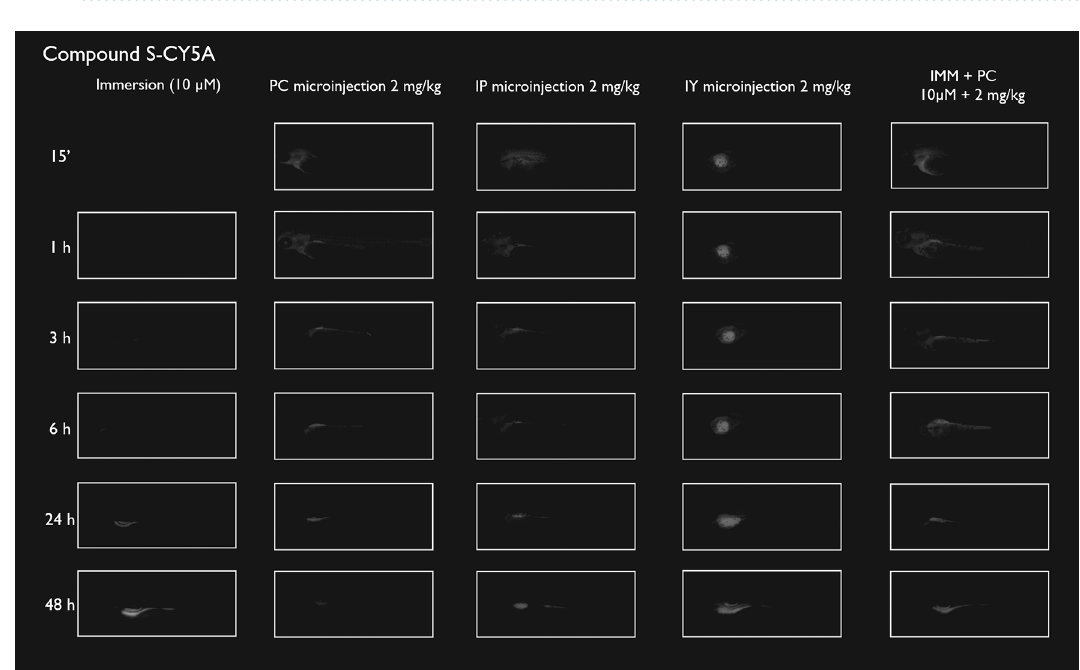
Figure 3. Representative pictures of the spatiotemporal distribution of the fluorescent compound S-CY5A. The eleuthero-embryos were exposed to the dye by immersion (10 µM) or microinjection (2 mg/kg) in the pericardial cavity (PC), intraperitoneally (IP) and in the yolk sac (IY), or by a combination of immersion and PC microinjection, for 48 h starting from 3 dpf. Selected images arranged in MS PowerPoint and GIMP (version 2.10.24 https:// www. gimp. org/ 2021)